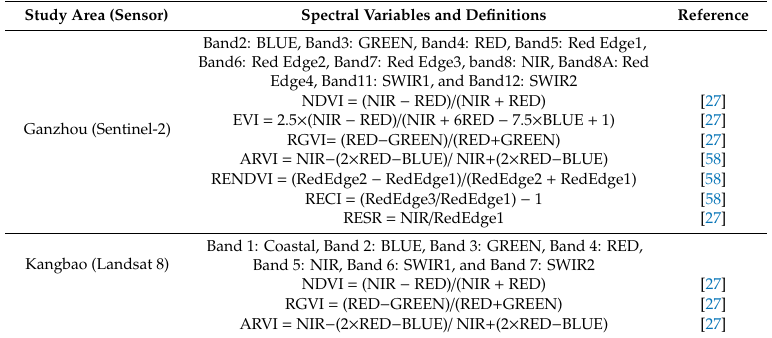
Table A1. Information on the images and spectral variables used in this